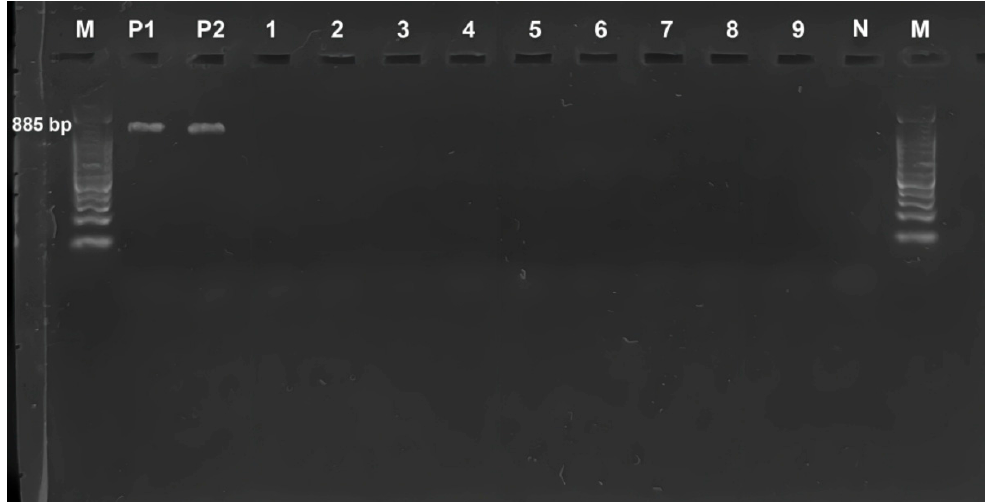
Figure 4. RT-PCR results for potato virus S (PVS) with an expected amplicon size of 885 base pairs (bps) performed on two PVS-infected mother plants (P1 and P2) and PVS-free plants obtained by ribavirin treatment B 14-1 RIB 50, B 14-3 RIB 100, and B14-4 RIB 50 in the following order: lines 1–3—R0 plants, lines 4–6—R1 plants from microtubers, lines 7–9—R1 plants form minitubers; N—negative control, M—marker (GelPilot 100 bp Plus Ladder, Qiagen, Hilden, Germany). For further details, please refer to Supplementary Table S1.